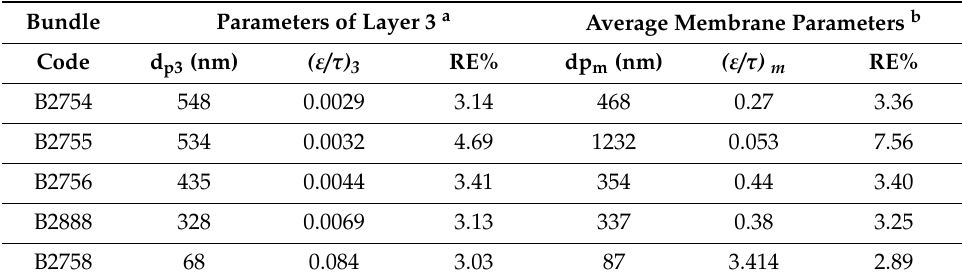
Figure 3. Pressure profiles along the radial coordinate of the membrane; elaborations of permeance data according to Equations (6) and (7). ( a ) Data from Figure 2b at P av = 3.1 bar (parameters in Table 1 — case b); ( b ) data from Figure 4 at P av = 3.3 bar (parameters in Table 3 — case a). Table 3. Capillary bundles: elaborations of gas permeance data.